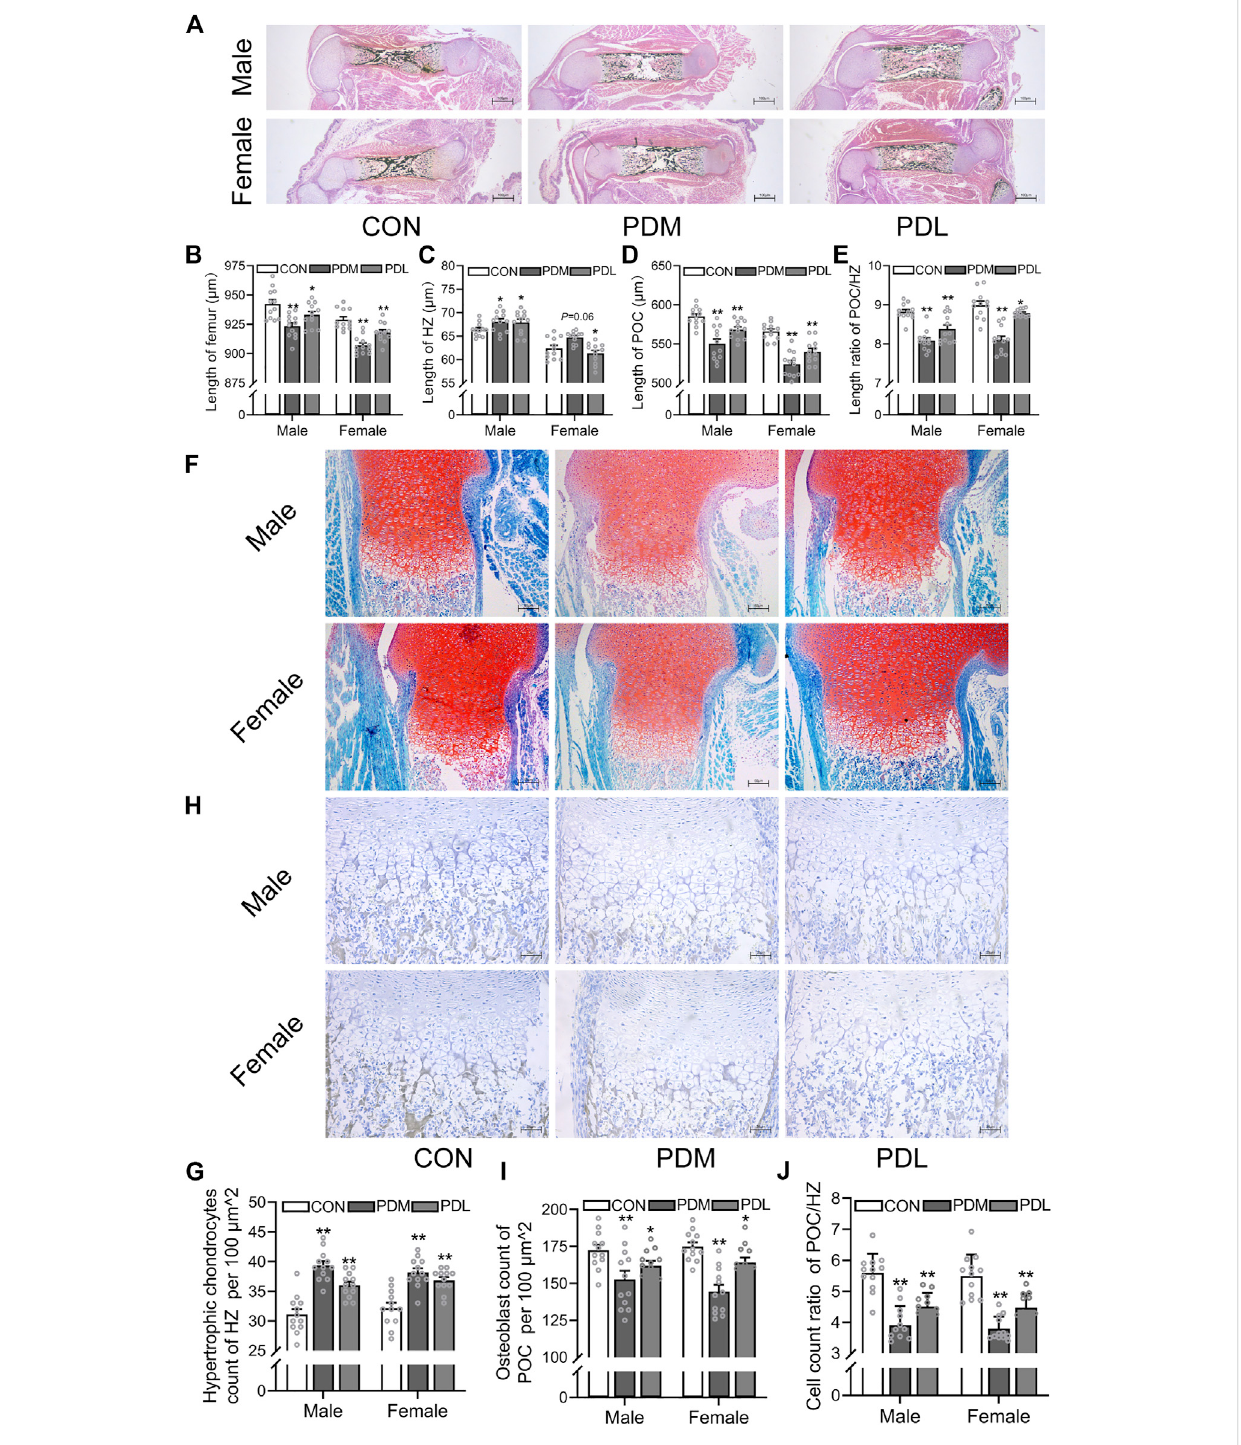
Effectsofdifferentstagesofdexamethasoneexposureonbonedevelopmentandchondrocyte-to-osteoblasttrans-differentiationinfetalmice. (A) . Typical images of vonkossa staining in fetal bone tissue; (B) . Quantitative analysis of fetal femur length; (C) . Quantitative analysis of the width of hypertrophy zone (HZ) in growth plate; (D) . Quantitative analysis of the length of the primary ossi fi cation center (POC); (E) . The ratio between the length of POC and the width of HZ of growth plate cartilage; (F) . Typical images of fetal bone tissue stained with saffron O and solid green; (G) . Analysis of hypertrophic chondrocytes number in growth plate cartilage; (H) . Typical images of alkaline phosphatase (ALP) in fetal bone tissue; (I) . Analysis of osteoblasts in the POC of fetal femur; (J) . The relative ratio of the osteoblasts number in the POC to the number of hypertrophiccells in the growth plate cartilage. * p < 0.05 , **p < 0.01 , CON v.s. PDM or PDL. CON, control; PDM, dexamethasone exposure in the middle-late trimester; PDL, dexamethasone exposure in the late